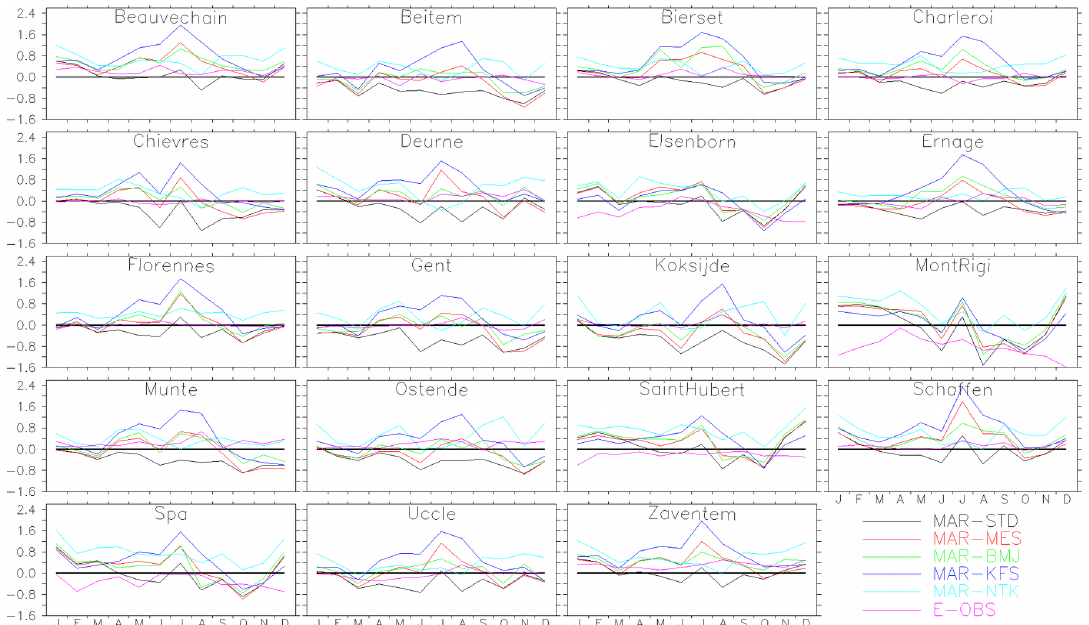
Figure 2. Monthly mean biases of daily precipitation simulated by MAR for each experiment and provided by E-OBS with respect to SYNOP observations (in mm/day).